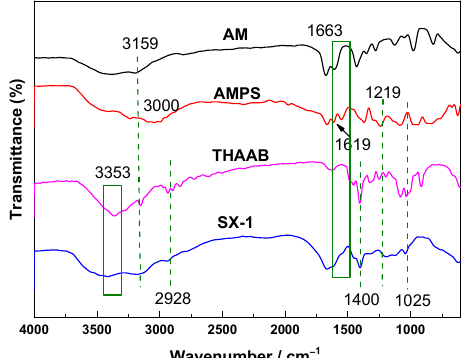
Figure 3. The FT-IR spectra of acrylamide (AM), 2-acrylamido-2-methyl propane sulfonic acid (AMPS), THAAB and SX-1.